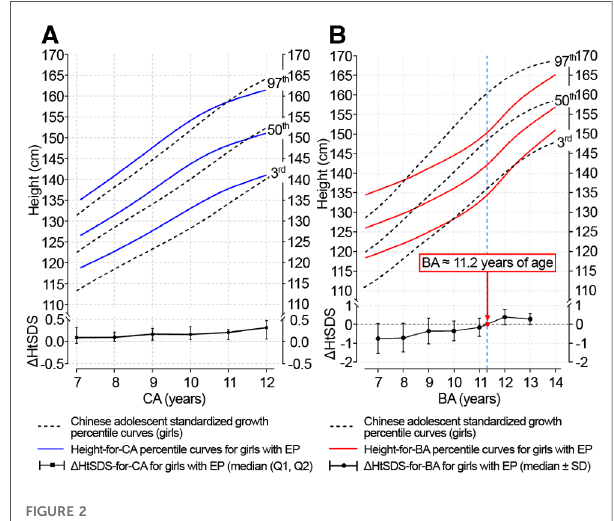
curves for the EP group deviated from the standardized growth curves, shifting downward, with the height gap increasing gradually. A turning point, indicative of catch-up growth, did occur at a BA of 11.2 years, with the height-for-BA curves for the EP group approaching the standardized reference growth curves.